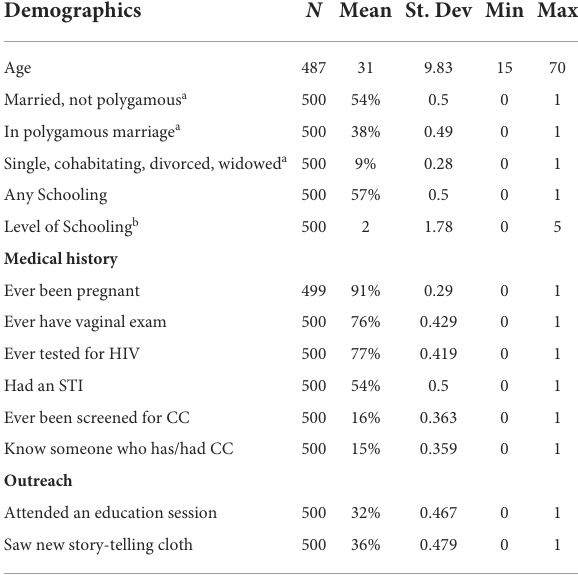
TABLE 2 Descriptive statistics for women participating in the study. TABLE 3 Participants’ desire for education sessions, n